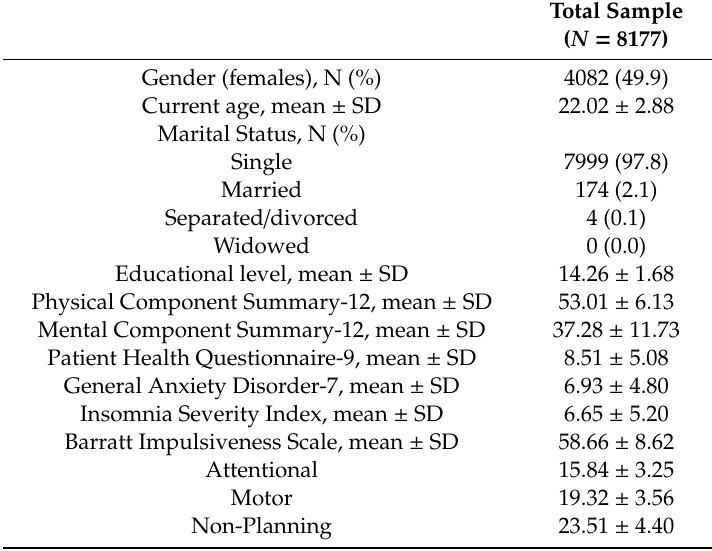
Table 1. Sociodemographic and clinical characteristic of the total sample